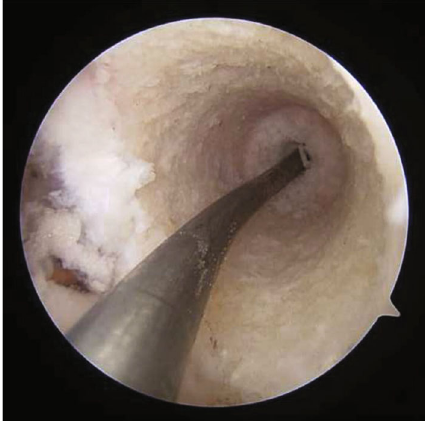
Figure 3: Arthroscopic view of the fl exible guide pin in the femoral tunnel, with no visible physeal cartilage observed.